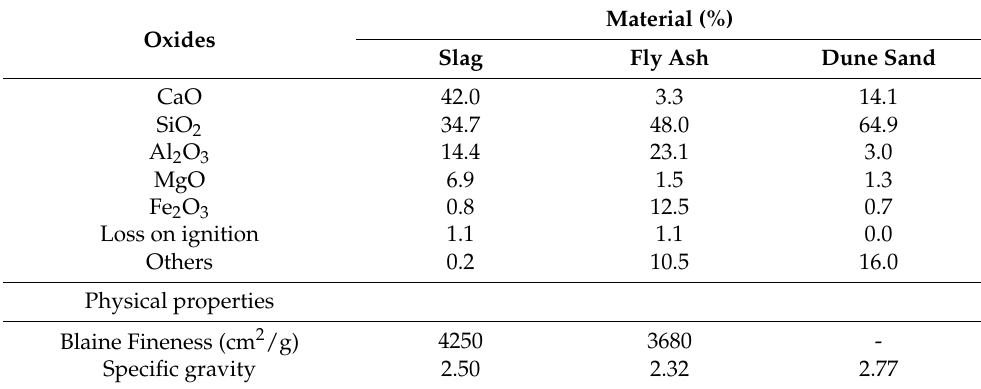
Table 1. Chemical composition and physical properties of slag, fly ash, and dune